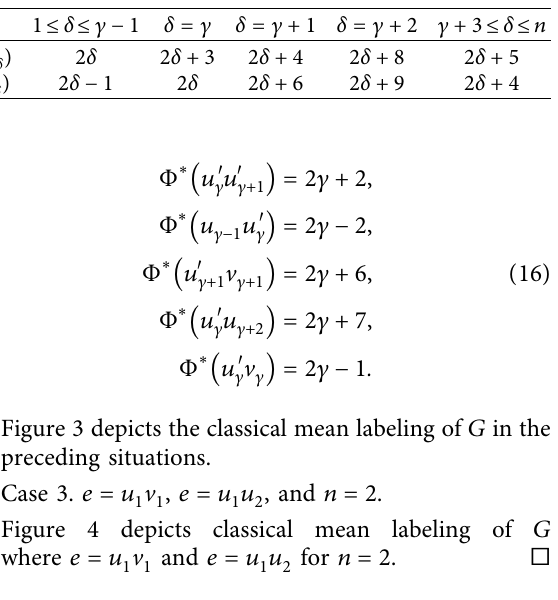
Table 17: Vertex labeling of Φ ( v